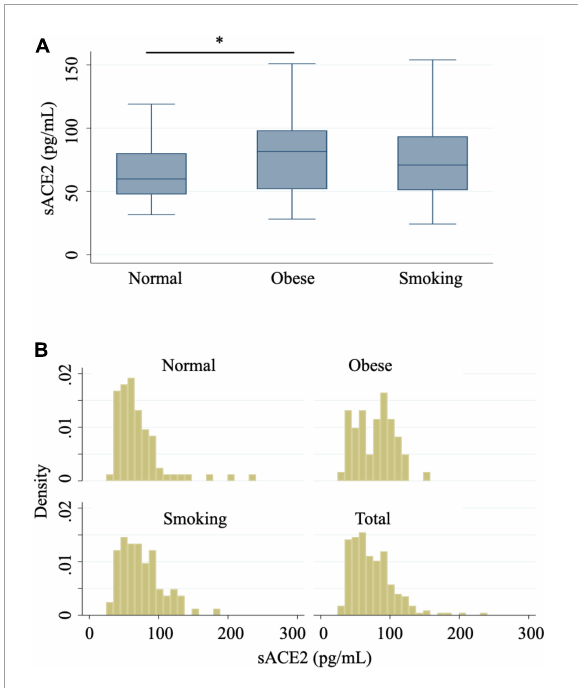
FIGURE1 Serum sACE2 levels in normal, obese, and smoking groups. (A) Box plots show serum sACE2 levels from normal, obese, and smoking groups. The Kruskal–Wallis equality-of-populations rank test, followed by Dunn’s pairwise comparison, was used to test between-group differences. ∗ p < 0.05. (B) Histograms provide a visual representation of data distribution in serum sACE2 levels from normal, obese, smoking, and total